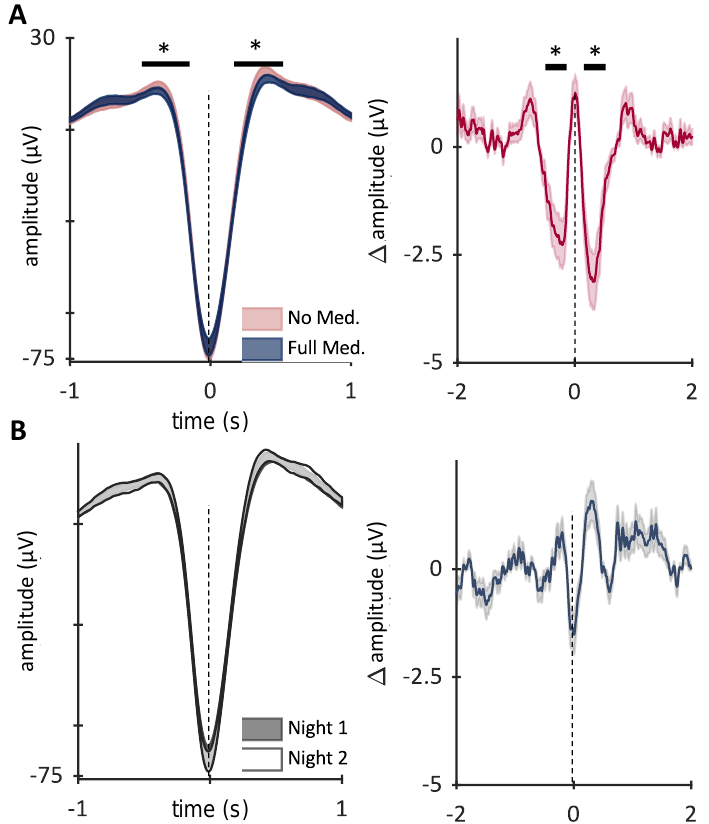
Figure 4. Slow wave peaks are reduced with anti-seizure medication. ( A ) Trough-locked Slow waves on nights without medication (red) compared to those with medication (blue). Slow wave peaks were lower on the ASM treatment night (blue, cluster permutation 10,000 iterations Cluster alpha 0.05, p = 0.014, p = 0.031, parametric dependent samples). On the right, the average difference between night for each patient (slow wave amplitude with ASM- no ASM) is quantified. That is, ASM use reduced slow wave peaks ~2.5 μ V. ( B ) No significant difference was found between two control nights. Graph shows mean ± SEM. * p < 0.05, ns p > 0.05.